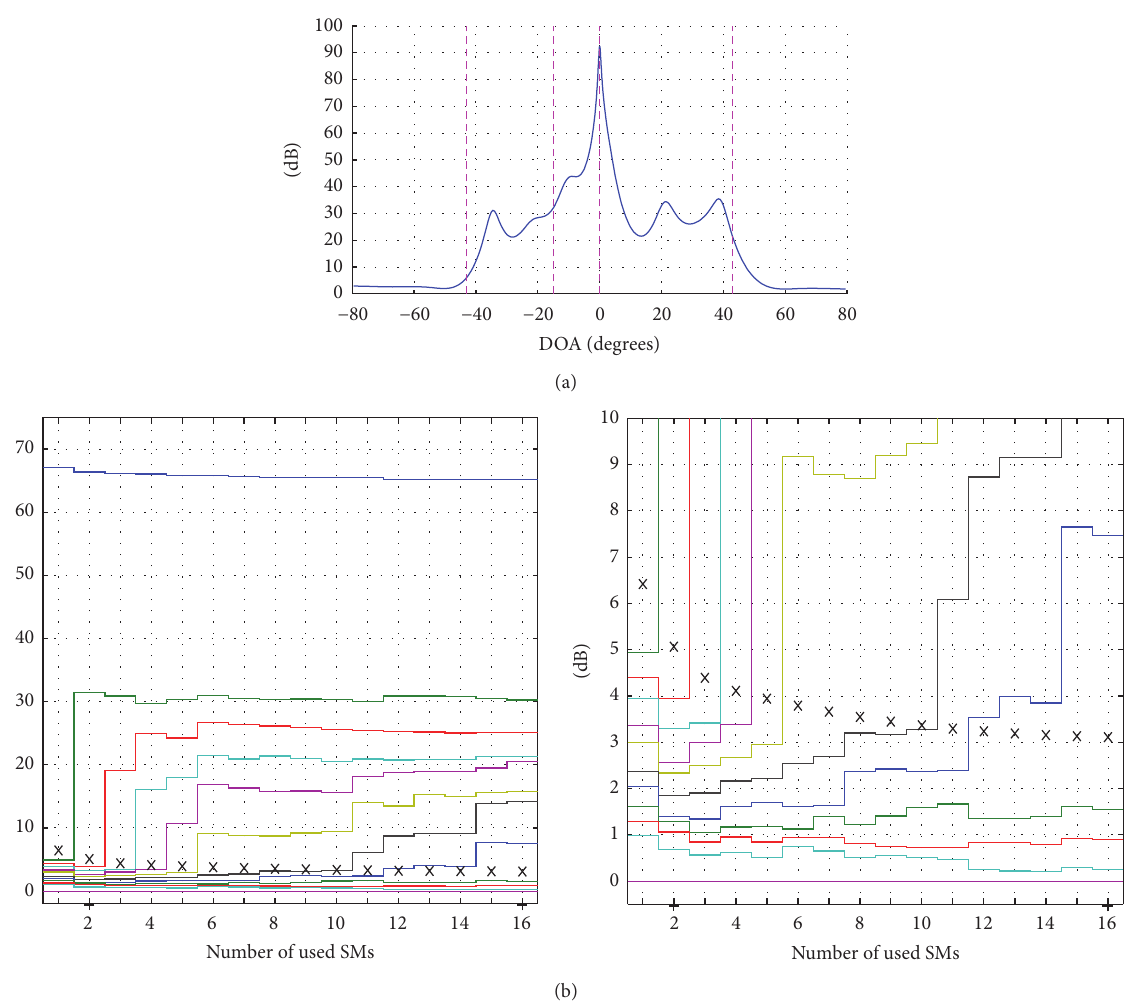
Figure 13: Measurement C2SW. Two coherent transmitters, one strong and one weak. (a) Capon DOA spectrum. (b) Eigenspectrum. Zoom- in to the right. dB scale. See Section 3.3 for